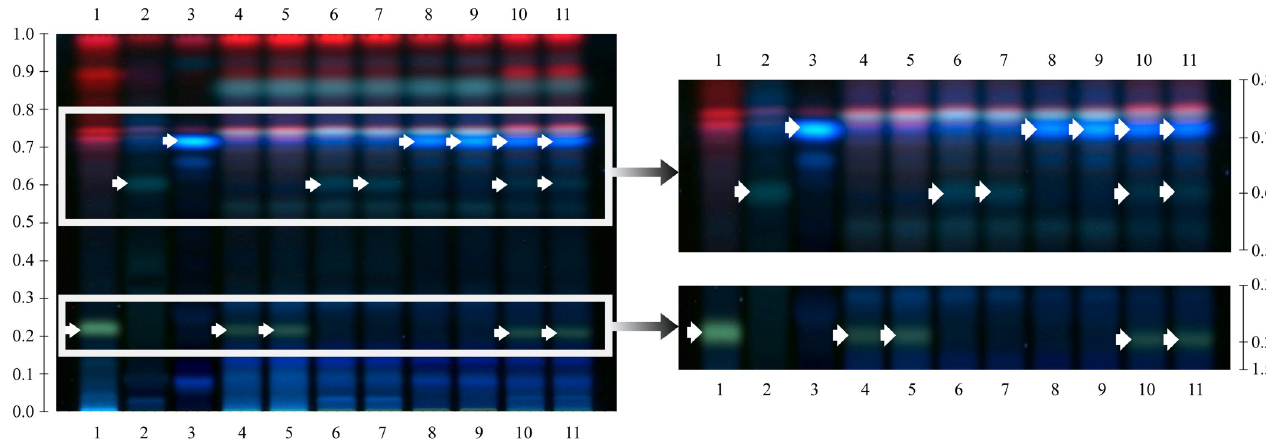
Fig 3. HPTLC chromatograms of ethanolic extracts of authentic species and four laboratory-made YPSKK formulae under UV at 366 nm. Track 1: A . cocculus , track 2: C . caudatus , track 3: M . repandus , tracks 4–5: F-A, tracks 6–7: F-C, tracks 8–9: F-M and tracks 10–11: F-ACM. A toluene:acetone:formic acid (5:4:0.5, v/v/v) mixture was used as the mobile phase. White arrows indicate the characteristic bands of each plant species.